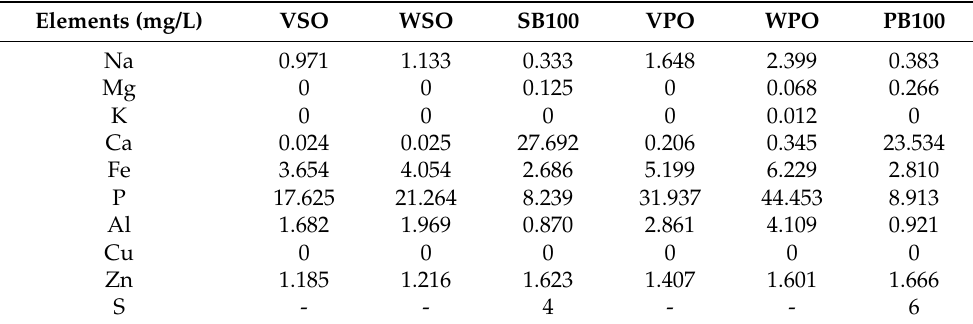
Table 5. Elements content in virgin oils, waste oils and biodiesels